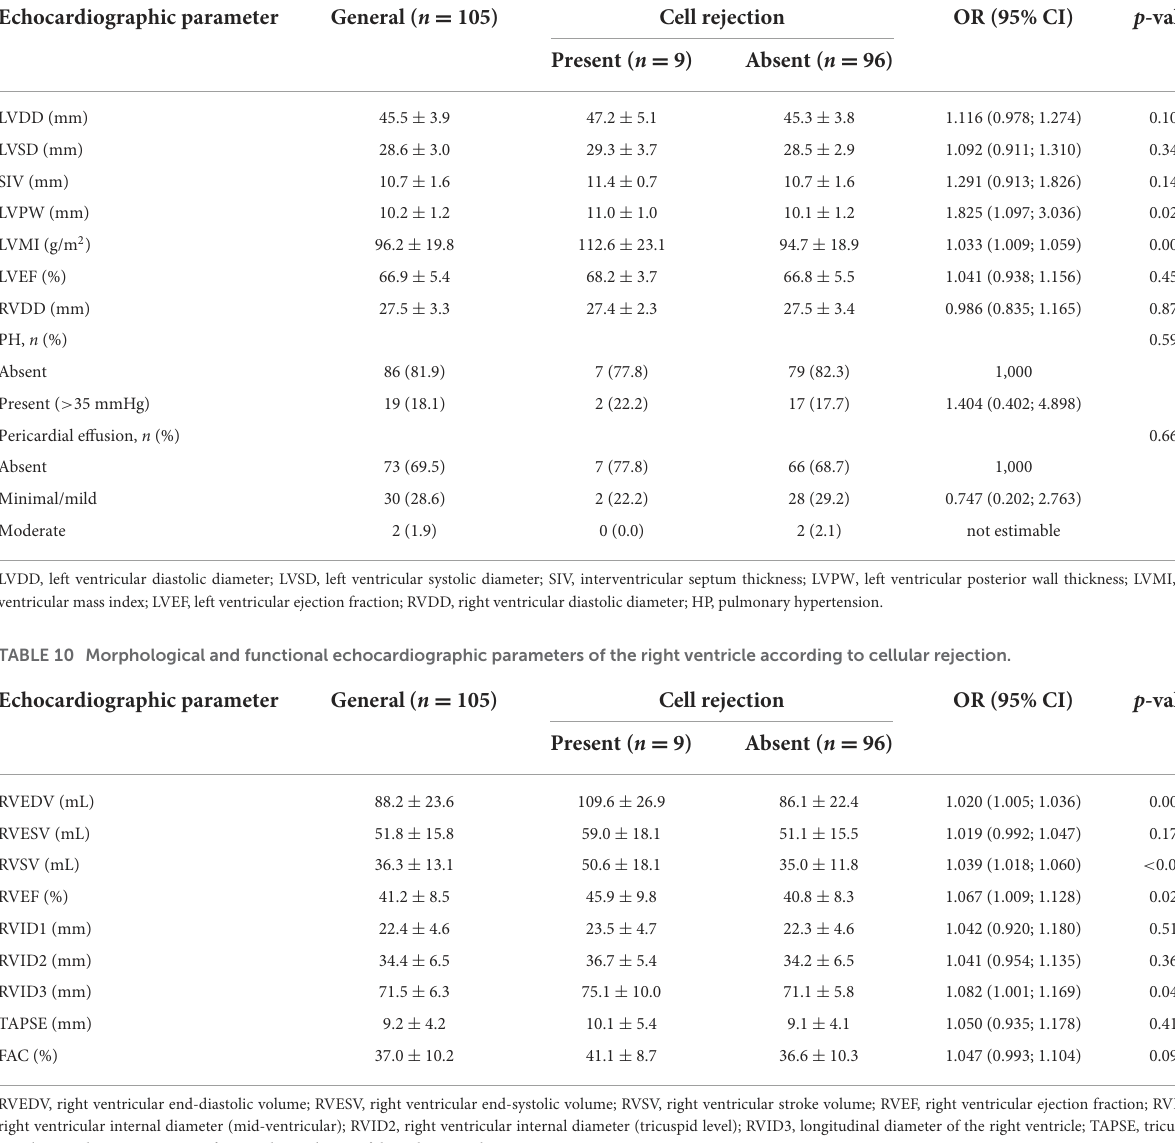
TABLE 9 Conventional echocardiographic parameters obtained by two-dimensional and descriptive evaluation according to cellular rejection. Echocardiographic parameter